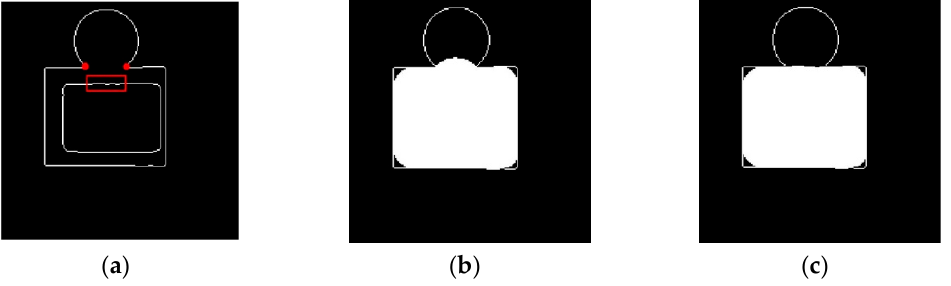
Figure 5. Liver segmentation enhancement method demonstration. ( a ) Original case, ( b ) result of the conventional dilation, ( c ) result of the proposed dilation.